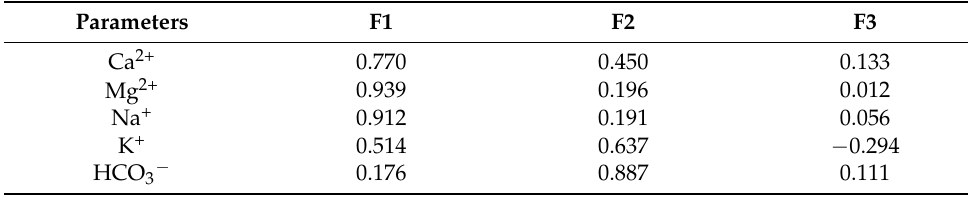
Table 4. Correlation between the parameters and